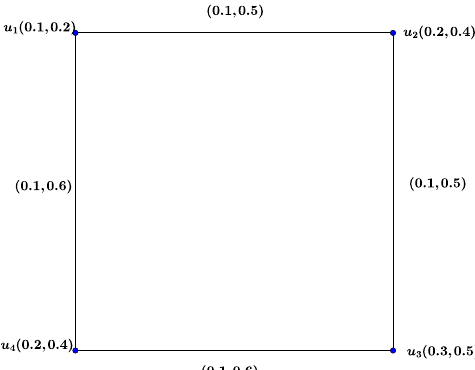
Figure 5. Vague graph G